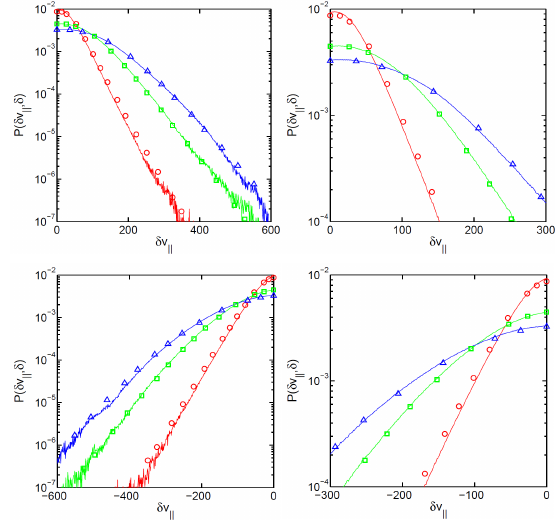
Fig. 6. Plots of P(δv || ,δ) : solid curves are from JHU data and mark- ers are from ROMA scaling relations: red (circles) for δ = 24 1 ; green (squares) for δ = 48 1 ; magenta (diamonds) for δ = 96 1 ; blue (triangles) for δ = 128 1 . (a) and (b) are for positive δv || ; (b) is an enlarged plot for δv || ≤ 300. (c) and (d) are for negative δv || ; (d) is an enlarged plot for δv || ≥− 300.